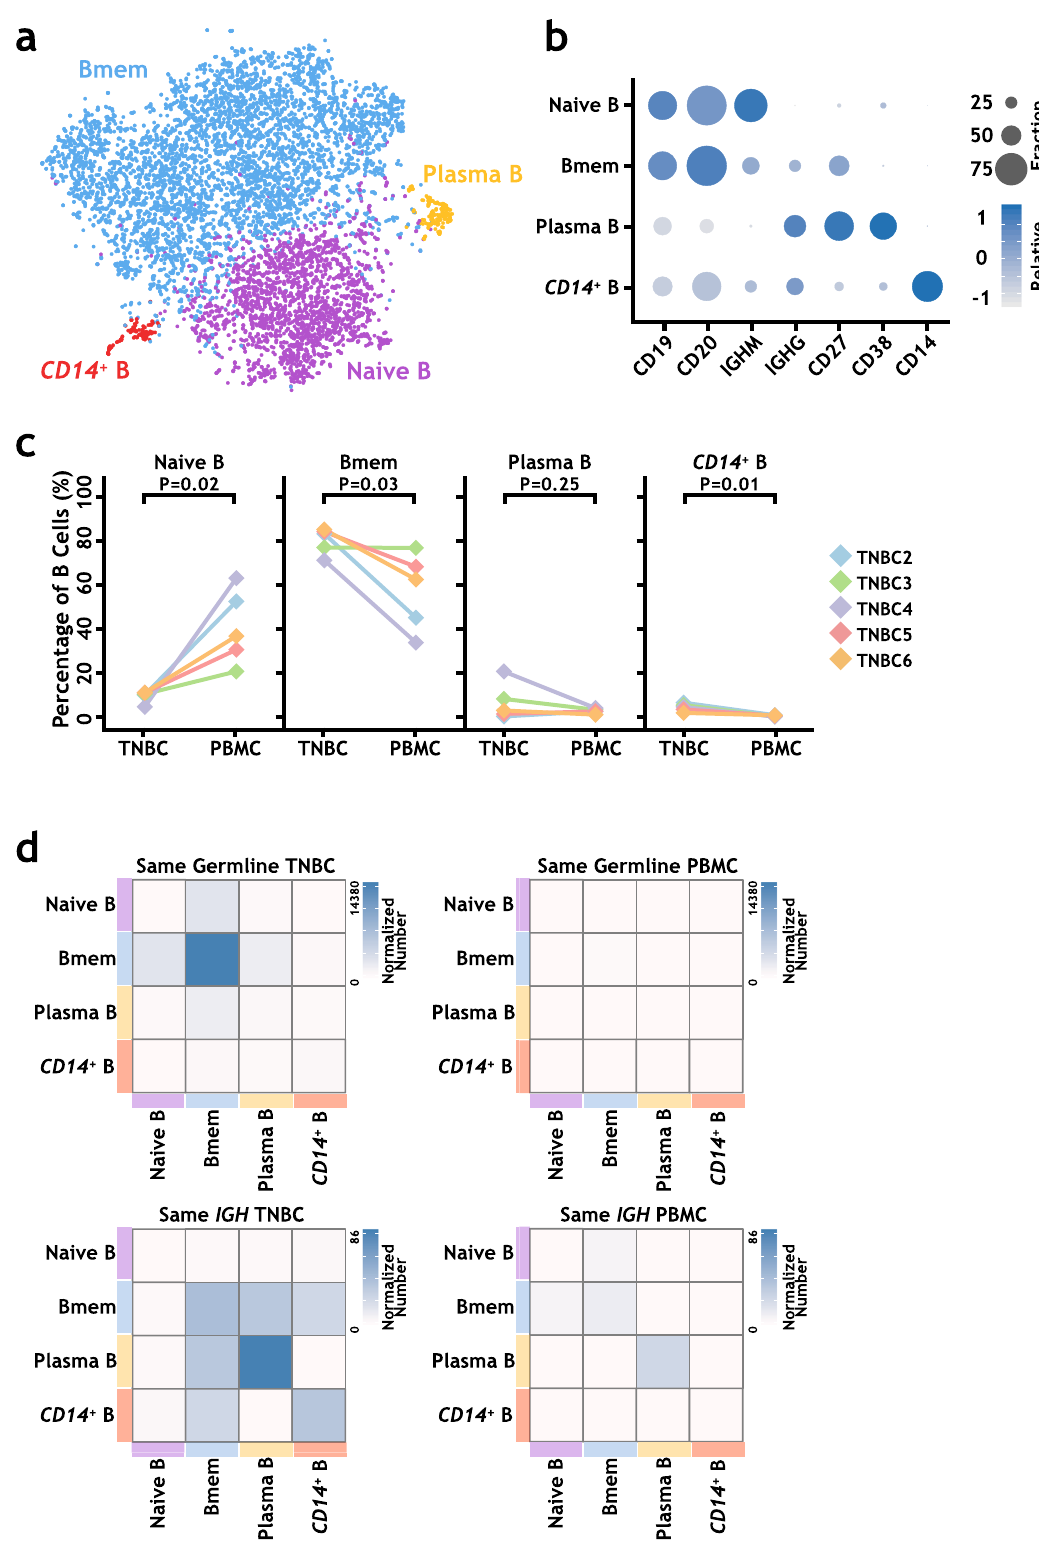
Fig. 3 Single-cell transcriptome analysis and IGH lineage analysis of B cells from TNBC patients at low resolution. a The t-SNE projection of 8632 B cells from TNBC patients shows four major cellular clusters. b Selected marker genes to de fi ne each B cell cluster. c The distributions of four clusters in each patient sample. The p values were calculated by two-tailed paired Student ’ s t test. d Heat maps show the distribution of the same IGH germline events (upper panel) and the same IGH sequence events (lower panel) among the four B cell clusters for TNBC and PBMC samples. The same germline events were calculated using clonally related B cells, and the same IGH sequence events were calculated using B cells with the same observed IGH sequences. Then, the event numbers were normalized by the cell numbers of related B cell clusters and plotted in the heatmap. See “ Paired BCR and single-cell RNA-seq data analyses ” in the “ Methods ” section for details. Source data are provided as a source data fi le. NATURE COMMUNICATIONS| (2021) 12:2186